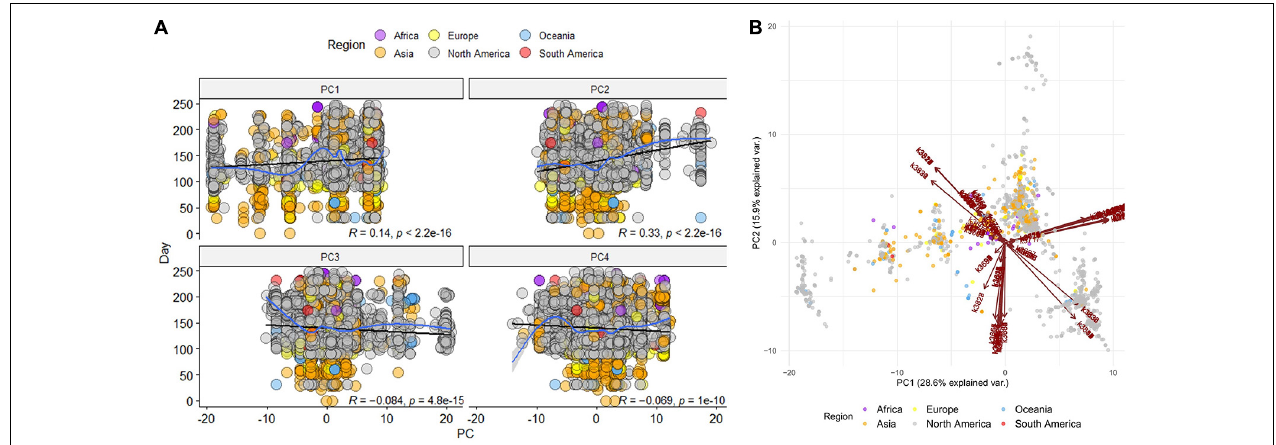
FIGURE 3 | Unsupervised Principal Components Analysis of the selected sequences ( n = 236) (A) Time correlation for every principal component (PC) (B) Projection of all raw sequences on the PC1 – PC2 space along with their demographic meta data. Arrows correspond to the k -mers that are projected on PC1 and